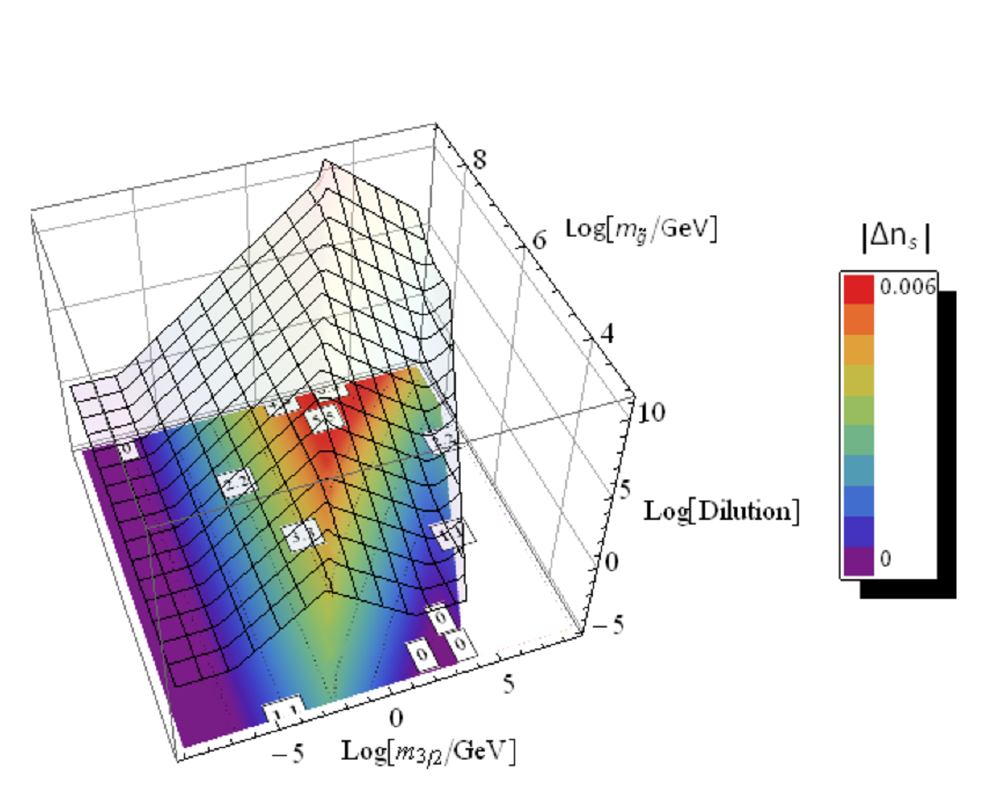
Figure 7 . This is a compound plot consisting of 3D graph and a density-contour plot. The 3D graph shows the decadic logarithm of the required dilution magnitude as a function of the gravitino LSP and gaugino-sfermion masses with m ~ = m ~ g for a reheating temperature T rh = 10 9 GeV. The f dilution is calculated by requiring the (cid:10) h 2 not to exceed the observational bounds. The density- 3 = 2 contour plot demonstrates the change in the n s value, magni(cid:12)ed 1000 times on the contour labels, for in(cid:13)ationary models that predict a reheating temperature T rh = 10 9 GeV. The information that one extracts from this graph is that supersymmetric models (e.g. quasi-natural, split, high scale) can be compatible with the CMB data only for particular values for the scalar tilt n s